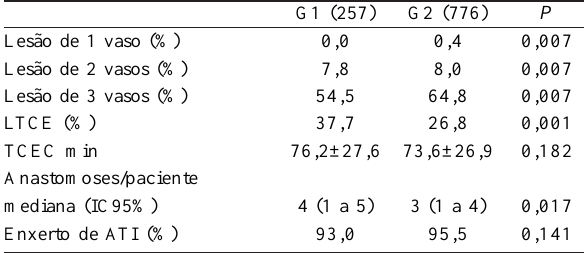
AVE=acidente vascular encefálico; BAVT=bloqueio atrioventricular